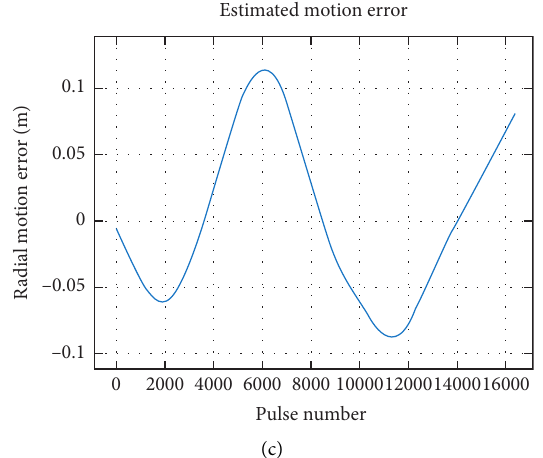
Figure 10: Images formed by the modified FFBP. (a) Uncompensated SAR image; (b) SAR image restored by PGA; (c) radial error extracted form phase error by PGA.